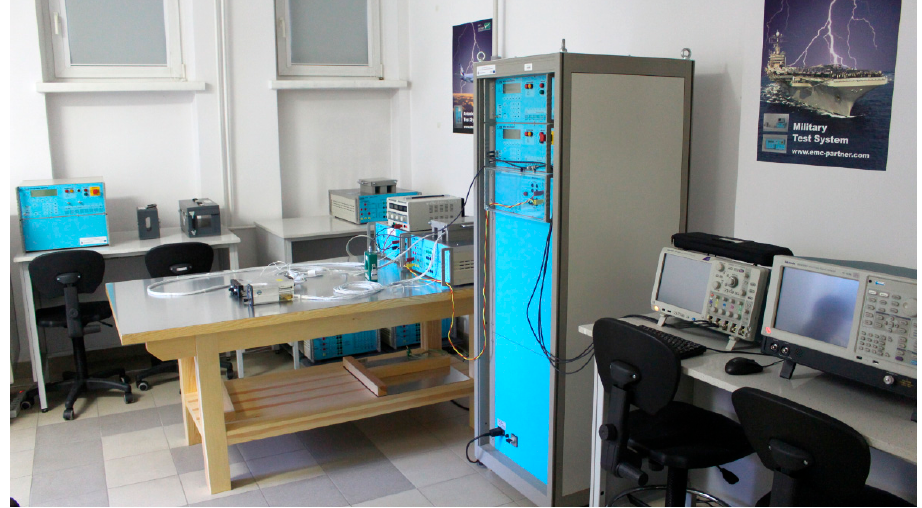
Figure 5. General view of the test stand dedicated to indirect lightning tests of avionics immunity.